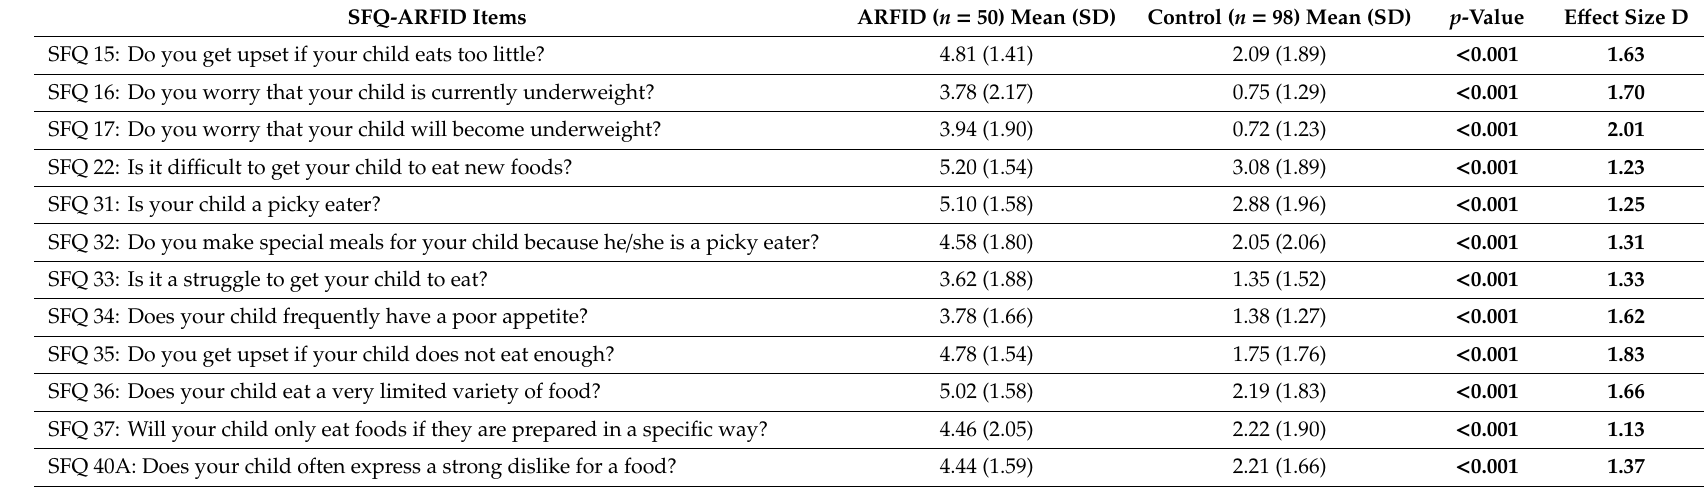
Table 1. Between-group di ff erences of the 12 items in the proposed SFQ-ARFID Scale. SFQ-ARFID Items ARFID ( n = 50) Mean (SD) Control ( n = 98) Mean (SD) p -Value E ff ect Size